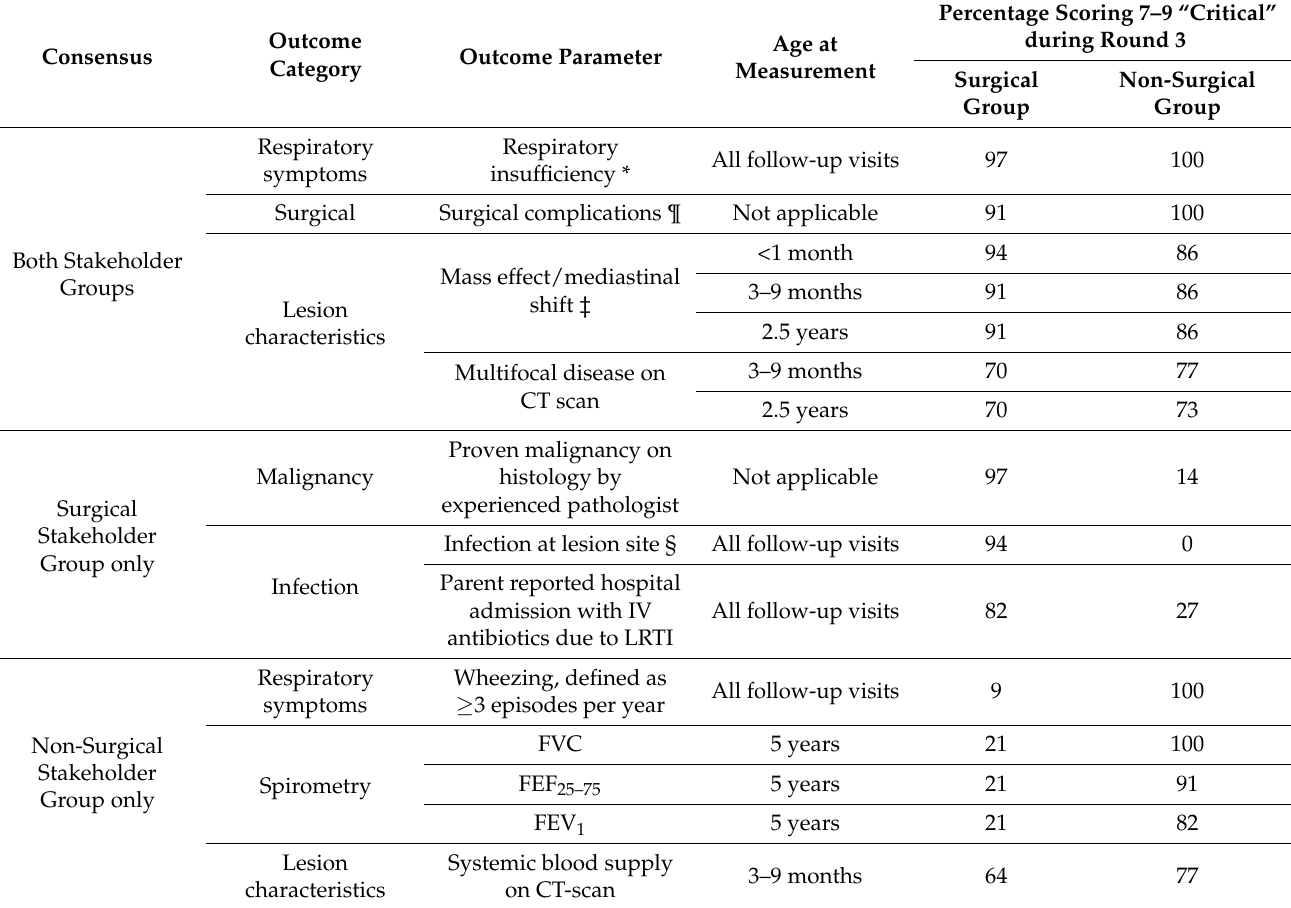
Table 3. Core outcome set per stakeholder group.